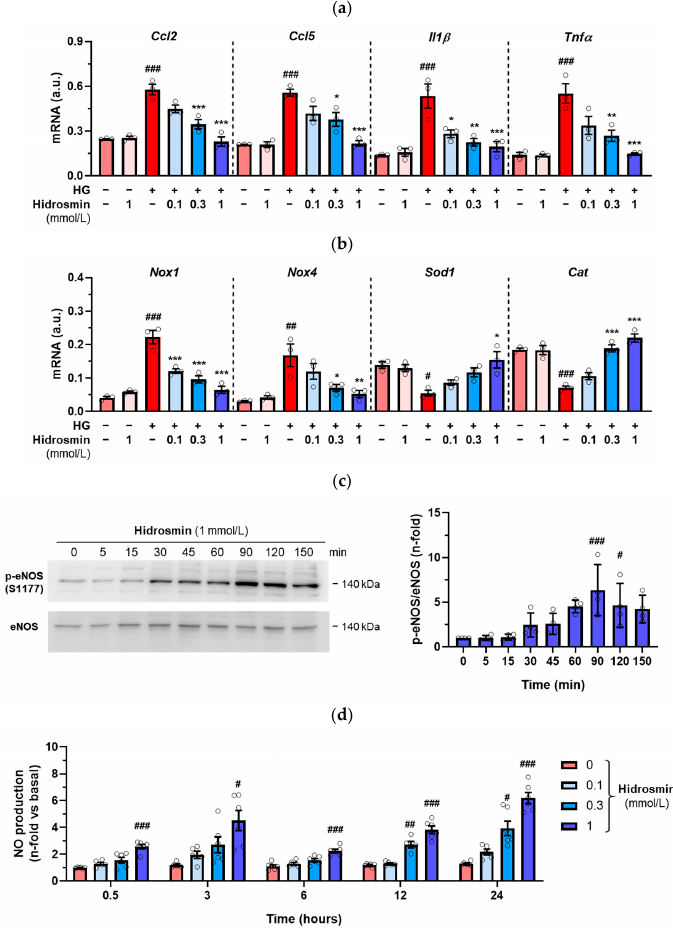
Figure 6. In vitro effects of hidrosmin. Real-time PCR analysis of inflammatory ( a ) and redox balance ( b ) genes in VSMC cultured under basal and high-glucose (HG) conditions without/with different concentrations of hidrosmin. Values normalized to 18S rRNA ( n = 3 independent experiments performed in duplicate) are expressed as arbitrary units (a.u.). ( c ) Time course of hidrosmin-induced eNOS phosphorylation in HMEC-1 cells. Representative immunoblots of p-eNOS (S1177) and total eNOS ( n = 4 experiments) and summary of normalized quantifications expressed as fold increases over basal are shown. ( d ) Time- and dose-response curves of hidrosmin-induced NO production in HMEC-1 cells. NO (nitrite + nitrate) levels in cell supernatants were normalized to protein content ( n = 4–6 experiments). Graphs represent individual values and mean ± SEM. # p < 0.05, ## p < 0.01 and ### p < 0.001 vs. basal; * p < 0.05, ** p < 0.01 and *** p < 0.001 vs. HG.